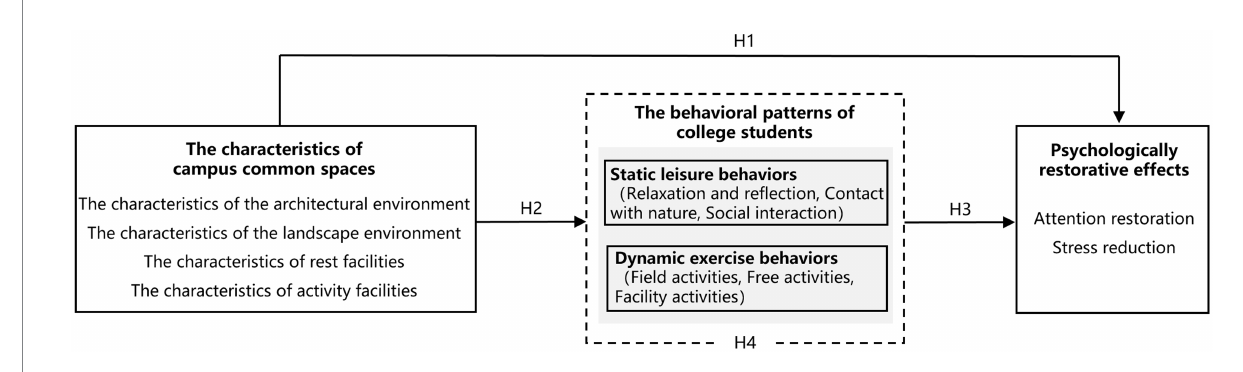
FIGURE 2 Hypothetical model of the psychologically restorative effects of campus common